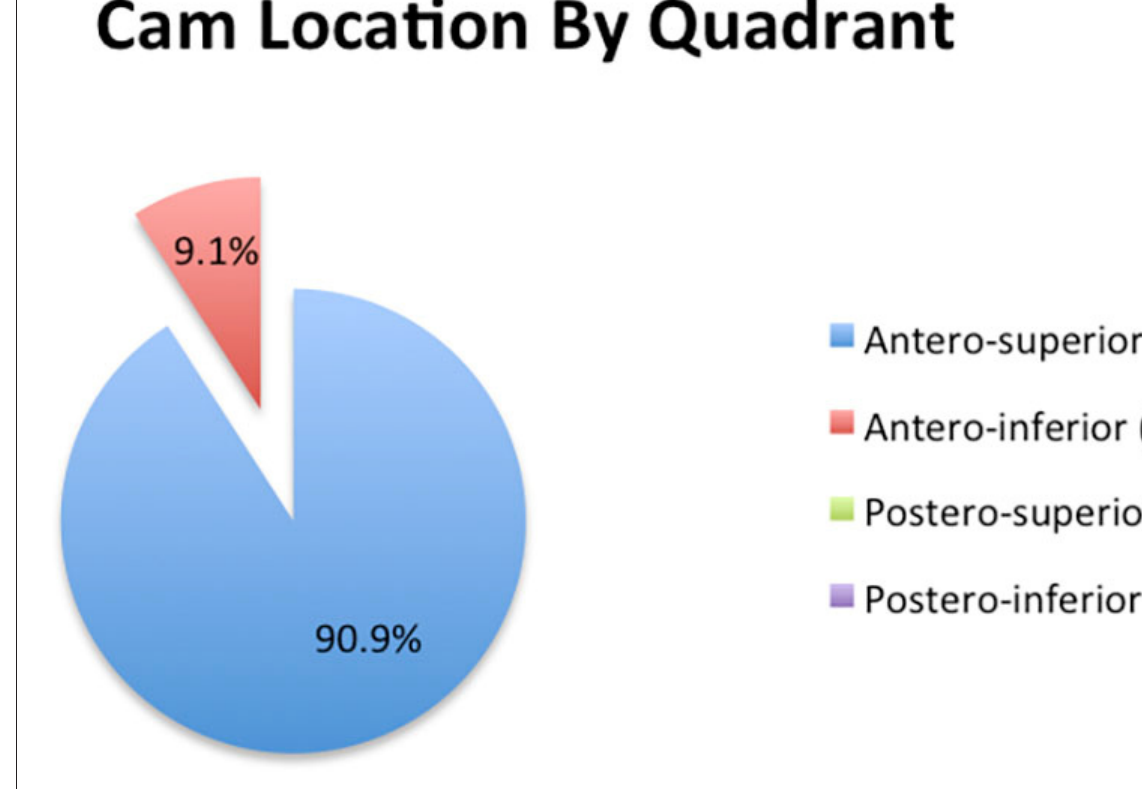
FIGURE 5 | The location of cam lesions when stratified by